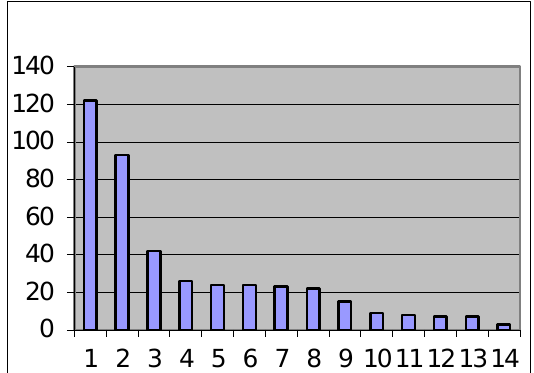
Figure 6. Number of archeologists in individual regions of the Czech Republic. 1 – Praha (122 archaeologists); South Moravia (93); Plzeň (42); Olomouc (26); South Bohemia (24); Central Bohemia (24); Ústí nad Labem (23); Hradec Králové (22); Moravian-Silesian Region (15); Pardubice (9); Liberec (8); Zlín (7); Vysočina Region (7), Karlovy Vary